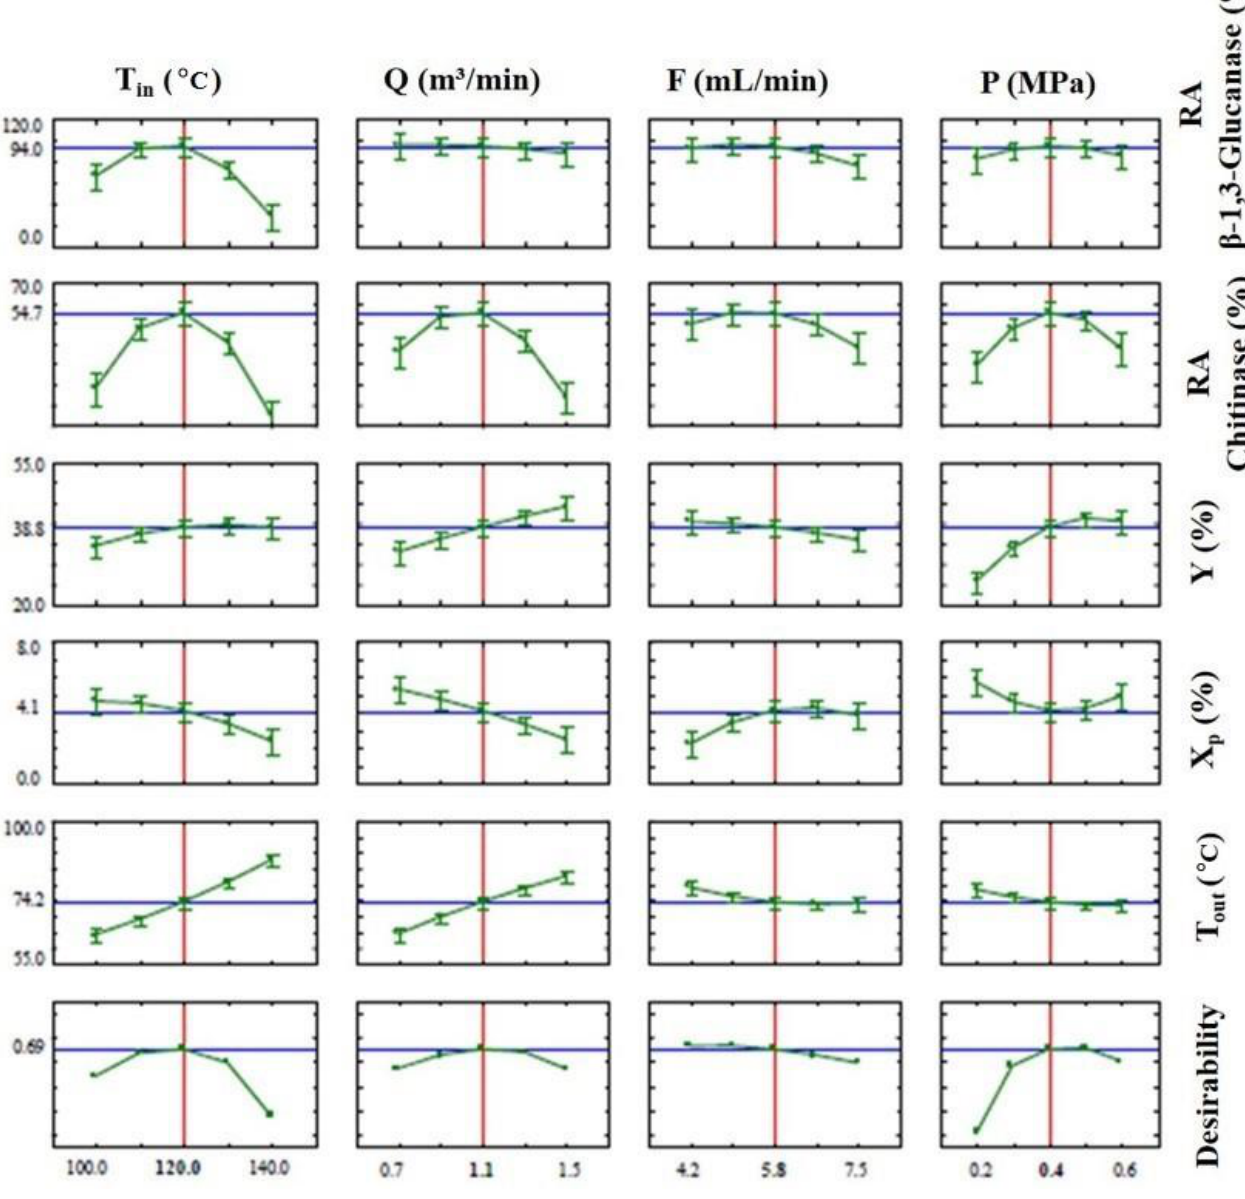
Figure 4. Desirability profiles of the spray drying optimization. T in : inlet air temperature; Q: